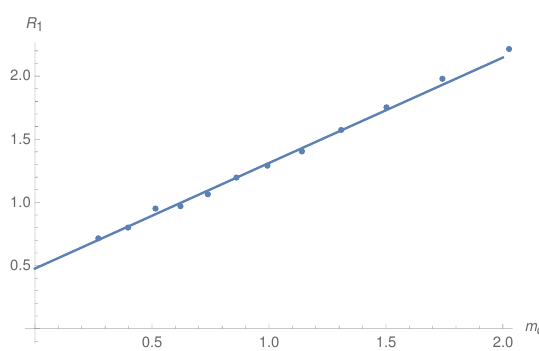
Figure 16 . Linear relation between the radius at which quarks are produced and their mass, obtained from the series of \maximal" loops on the boundary between regions (i) and (ii).